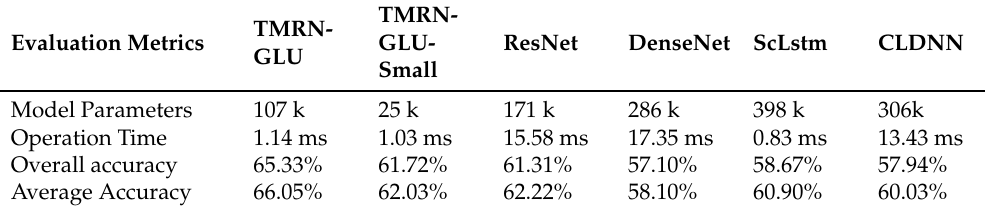
Table 4. Performance evaluation metrics for AMR